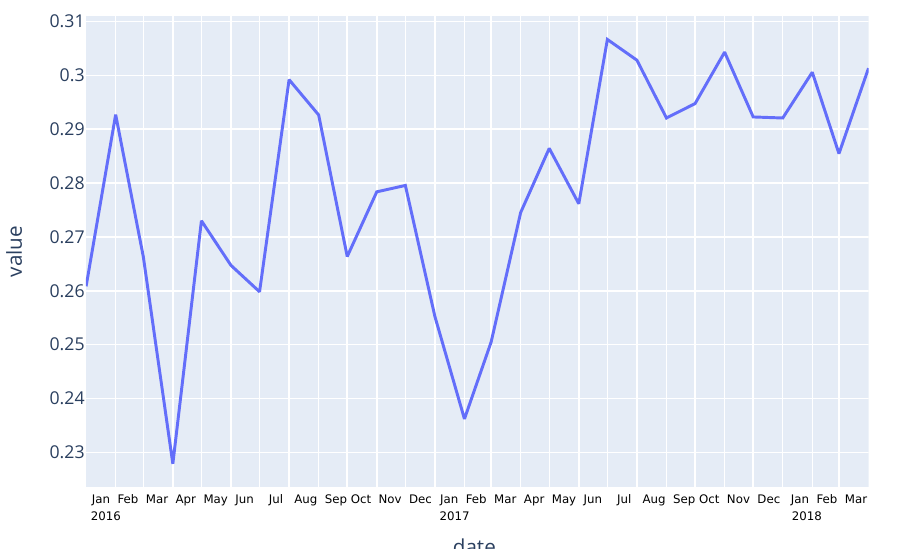
Figure 15. Example of satisfaction KPI (Colombia): positive reviews of the destinations. Obtained from OntoTouTra.